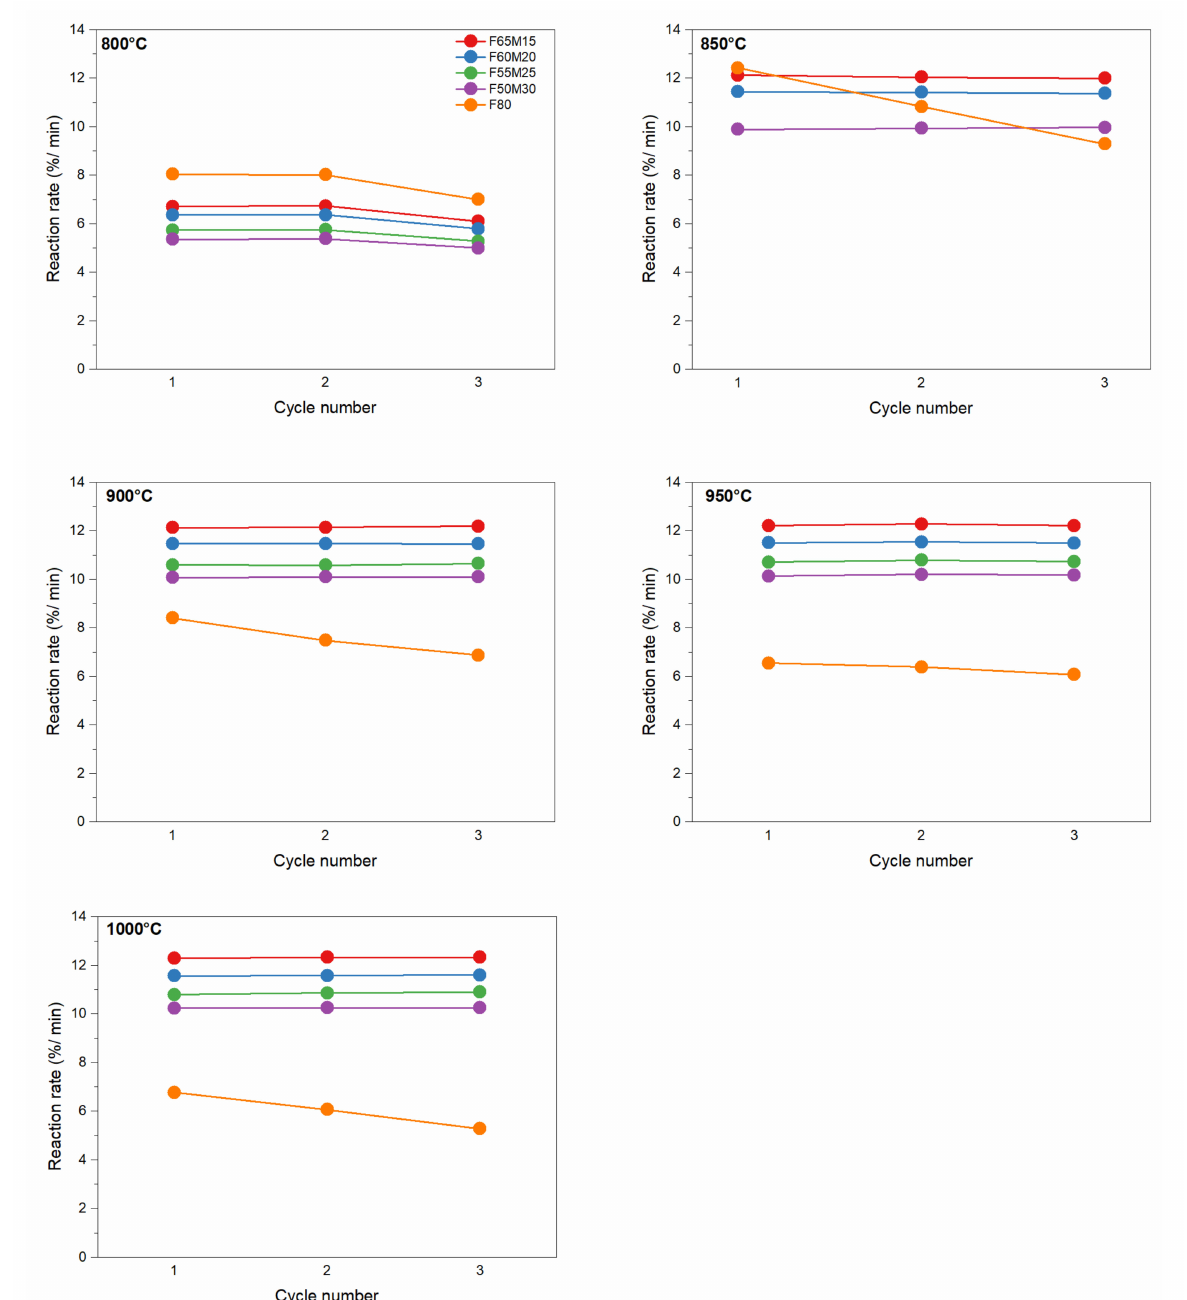
Figure 7. Oxidation reaction rate for OCs versus cycle number at given temperatures.